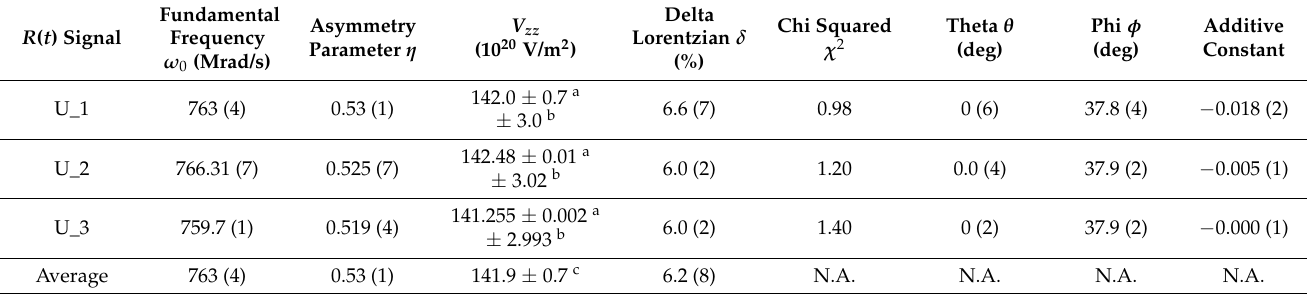
Table A1. Table of fitted hyperfine and experimental parameters for this set of 3 different e − γ TDPAC measurements of 181 Ta(TiO 2 ), returned by the Gfit19 TM program. It is noted that this set contains e − γ TDPAC signals corresponding to the unannealed case (Termed “U_”). For the individual values of V zz , the fit uncertainty is separated into (a) the statistical uncertainty caused by our instruments, and (b) the (dominant) systematic uncertainty of the quadrupole moment ( ± 2.1%) as quoted in reference [51]. The multiplicative constant of this set of e − γ TDPAC measurements is fixed at 1. The averaged values of ω 0 , η , and V zz from this set of e − γ TDPAC measurements were calculated, with (in the case of V zz , (c)) the uncertainty assigned the square root of the sum of squares of their statistical uncertainty (in the case of V zz , (a)).